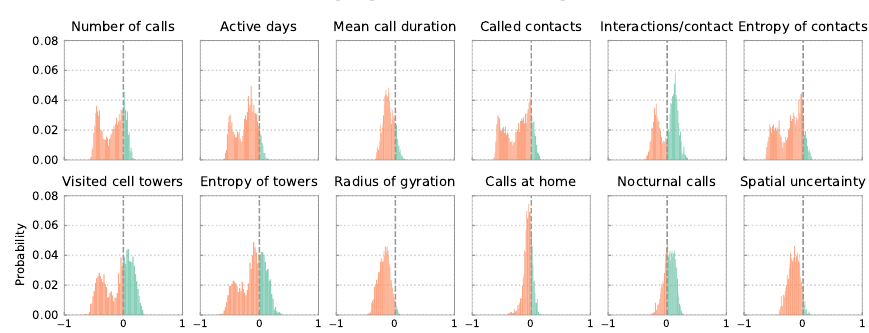
Figure 6. Distributions of the Spearman correlation coefficient for the relation between the Segregation index and a selection of mobile phone indicators calculated for all 4914 city definitions. The histogram is colored green when correlation coefficients are positive and orange when